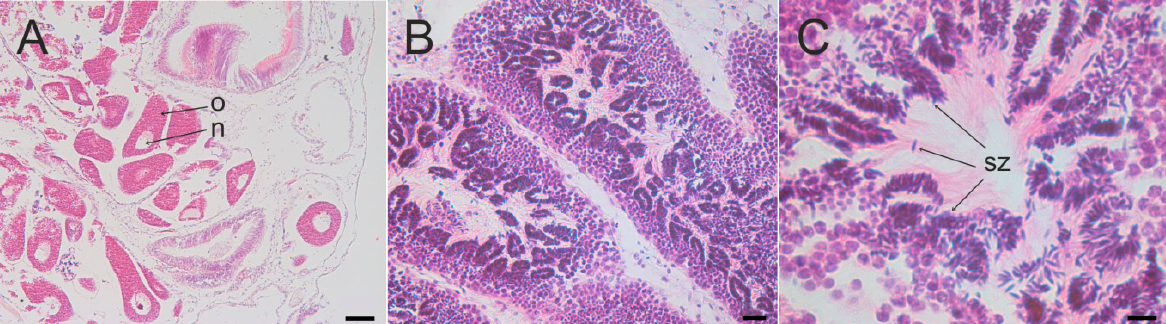
Figure 3. Gonad histology of Corbicula tobae from Lake Toba, North Sumatra, Indonesia (lot Nos. RMBH MCorb-17 and RMBH Corb-93): ( A ) section of the female gonad; ( B ) section of the male gonad; ( С ) aggregations of spermatozoa. Abbreviations: o, oocyte, n, nucleus; sz, spermatozoa. Scale bars = 100 µm ( A ), 20 µm ( B ), and 10 µm ( C ). The analysis of C . tobae sperm revealed the presence of relatively small monoflagellate spermatozoa (Figure 3C, Table 1). The average head length (SD) of the spermatozoa was 3.8 µm (min − max 3.4 − 4.4 µm) (N = 50).